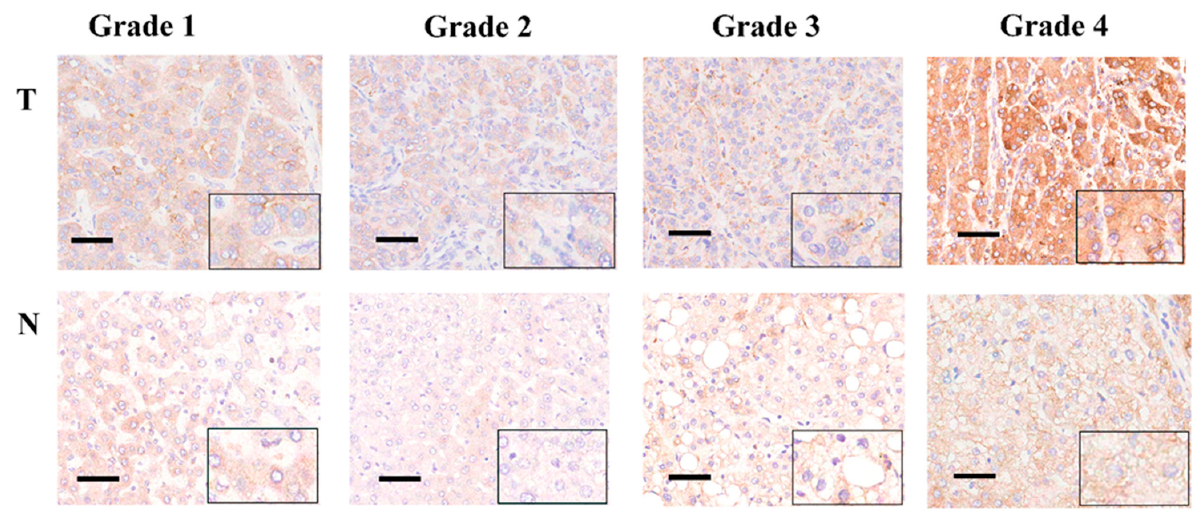
Figure 2. TMAs and IHC analysis of POGK expression in matched HCC tissues from patients with tumor grade 1 to 4. Top row: tumor tissues. Bottom row: adjacent normal tissues. The boxed area of each image is shown at a higher magnification in the inset. (Scale bars, 100 μ m).